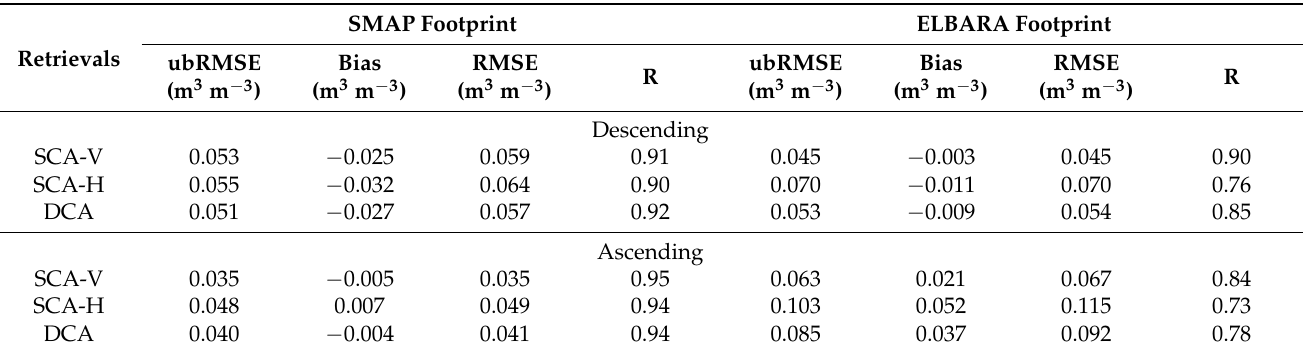
Table 3. Statistical errors estimated between the in situ average θ liq and retrievals obtained by the SCA-V, SCA-H and DCA algorithms using either the ELBARA-III or SMAP measured T B p during the ascending and descending overpasses between August 2016 and July 2017.